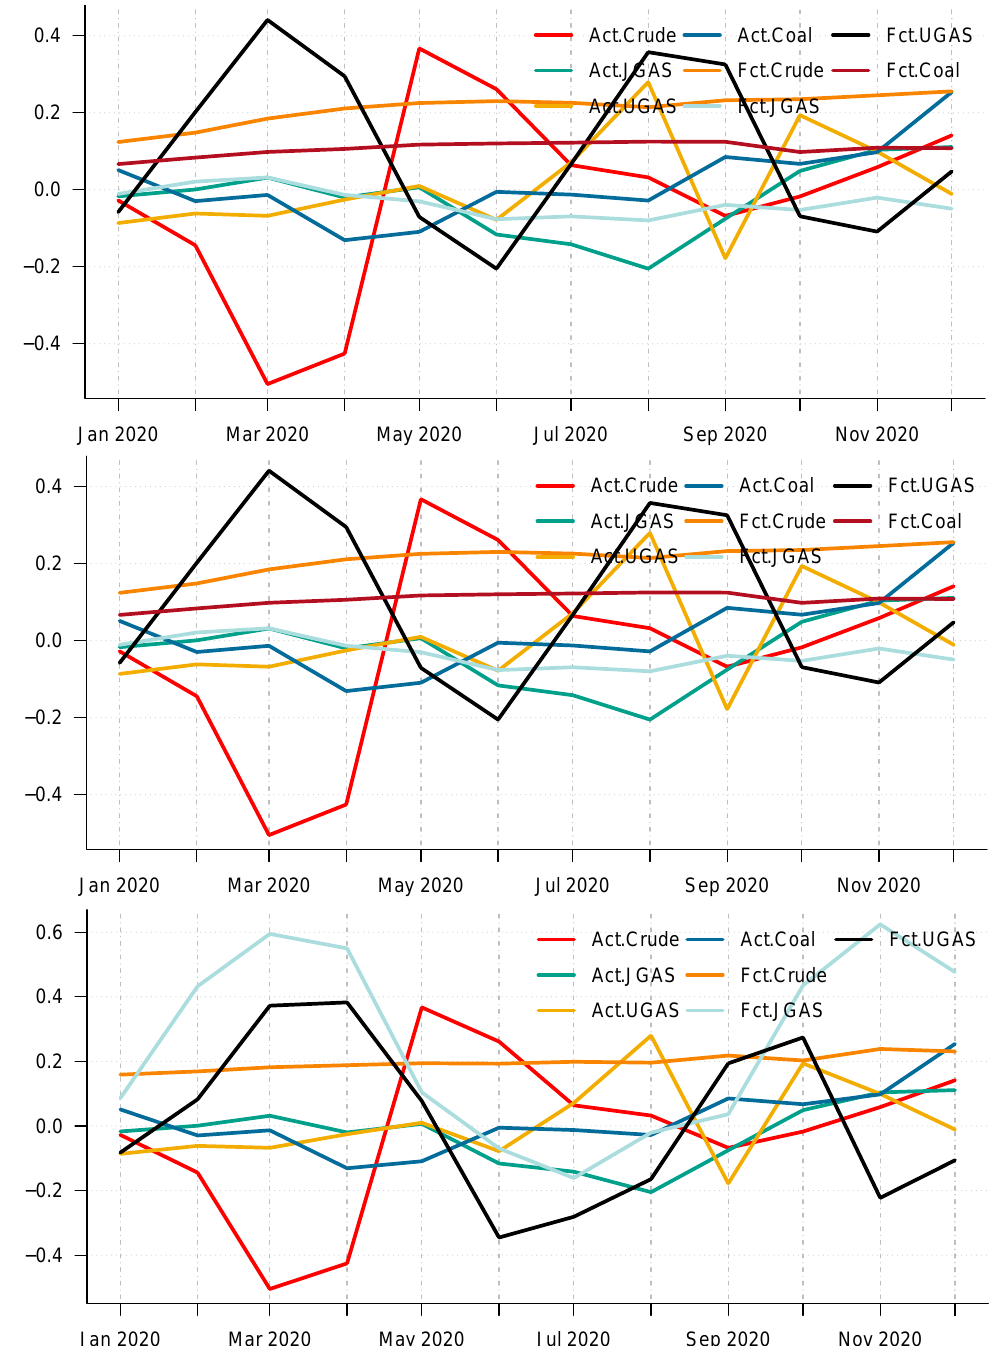
Figure 14. Actual price return series versus price return forecast of (CEEMDAN-ELM, EEMD-ELM, EMD-ELM) hybrid models in 2020. ( top ) Panel A: Actual price return series versus CEEMDAN-ELM- based price forecast of crude oil, gas, and coal in 2018. ( middle ) Panel B: Actual price return series versus EEMD-ELM-based price return forecast of crude oil, gas, and coal in 2019. ( bottom ) Panel C: Actual price return series versus EMD-ELM-based price return forecast of crude oil, gas, and coal in